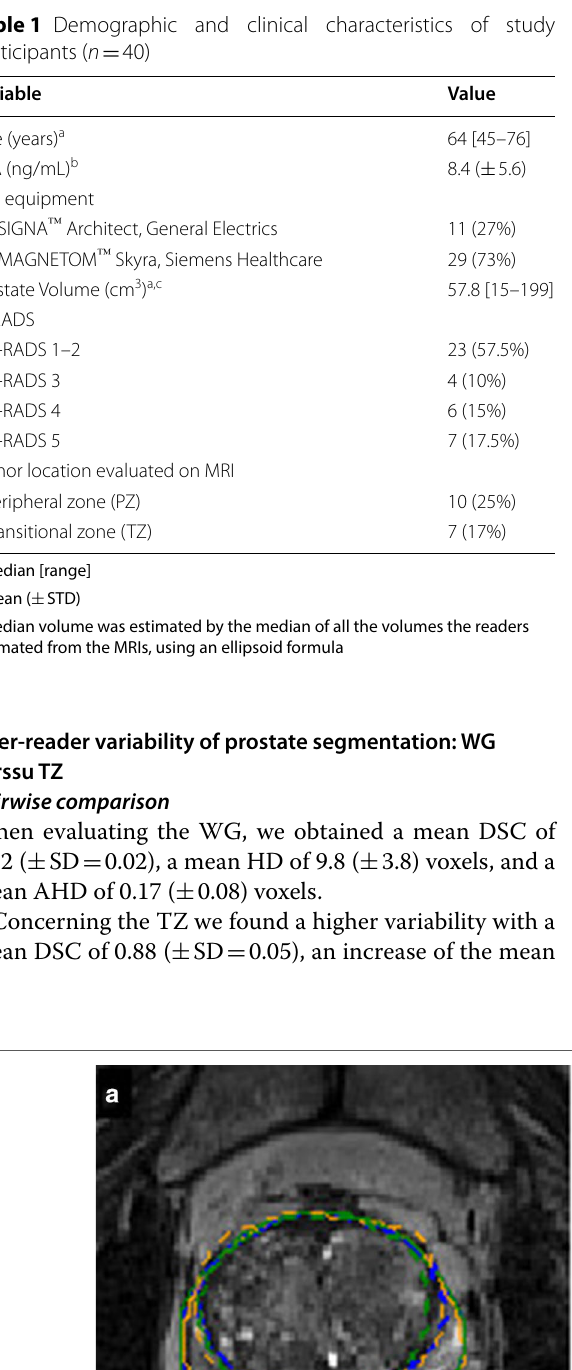
Table 1 Demographic and clinical characteristics of study